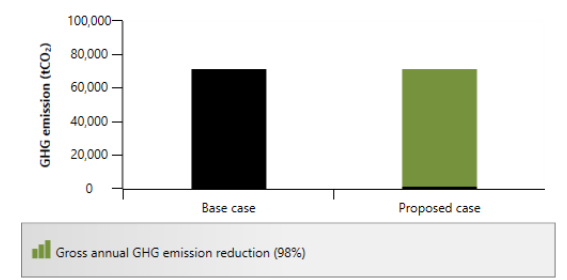
Fig. 5: Histogram of GHG Emission